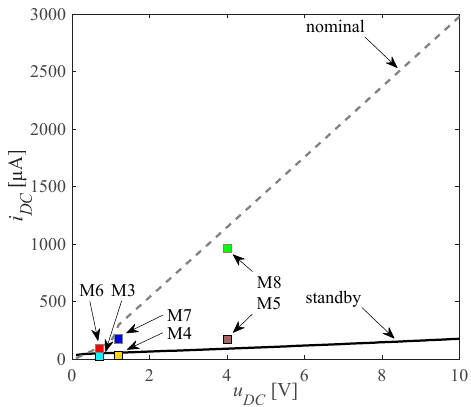
Figure 4. Current i DC vs. voltage u DC .